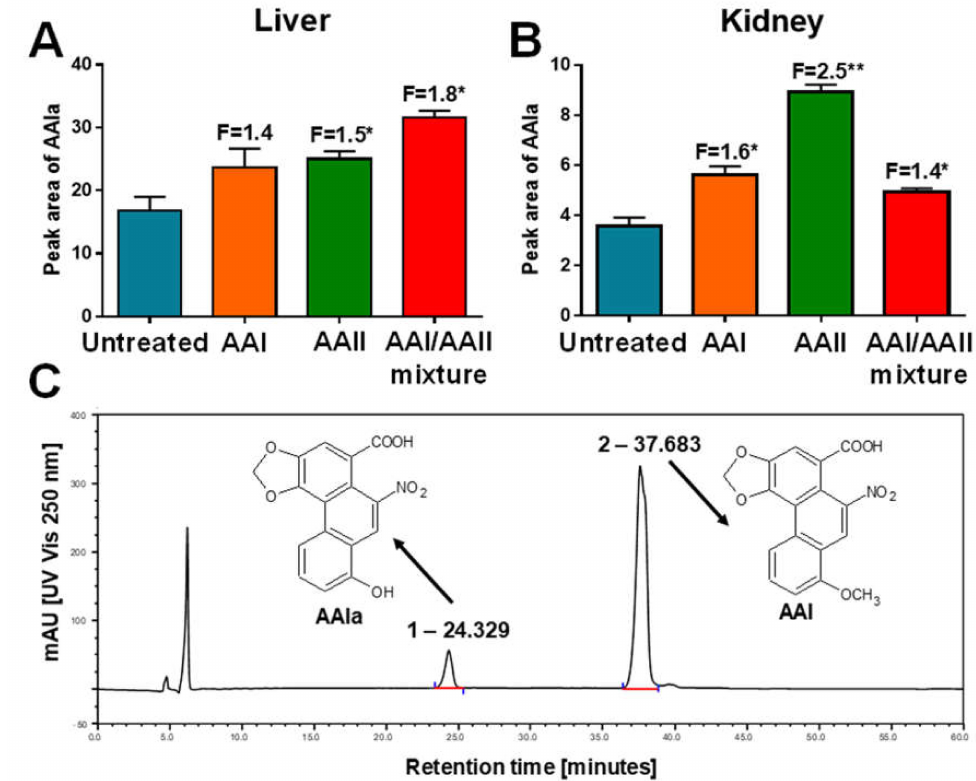
Figure 4. Oxidation of AAI to AAIa by microsomes of livers ( A ) and kidneys ( B ) from control (untreated) rats and rats pre-treated with AAI, AAII, or AAI/AAII mixture. All values are given as the means ± SD ( n = 3). Numbers above columns (‘F’) indicate fold changes in AAIa levels compared to control (untreated). Comparison was performed by t -test analysis: * p < 0.05, ** p < 0.01, differences from control (untreated). Representative HPLC chromatographs of AAIa metabolite (peak r.t. at 24.3 min) and AAI (peak r.t. at 37.7 min) produced by rat microsomes incubated with AAI and NADPH ( C ). The peaks with the characteristic AAI metabolite (AAIa) and the parent AAI are indicated in the